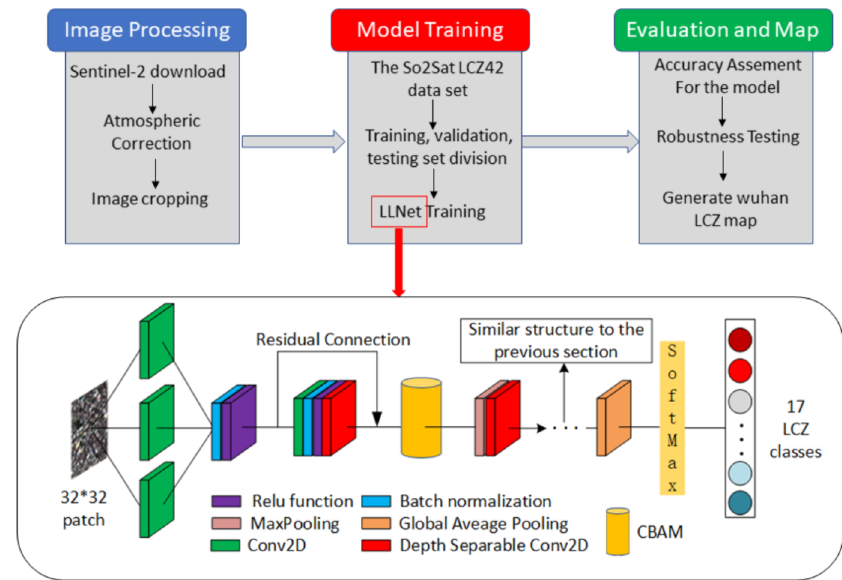
Figure 1. Classification workflow and structure of